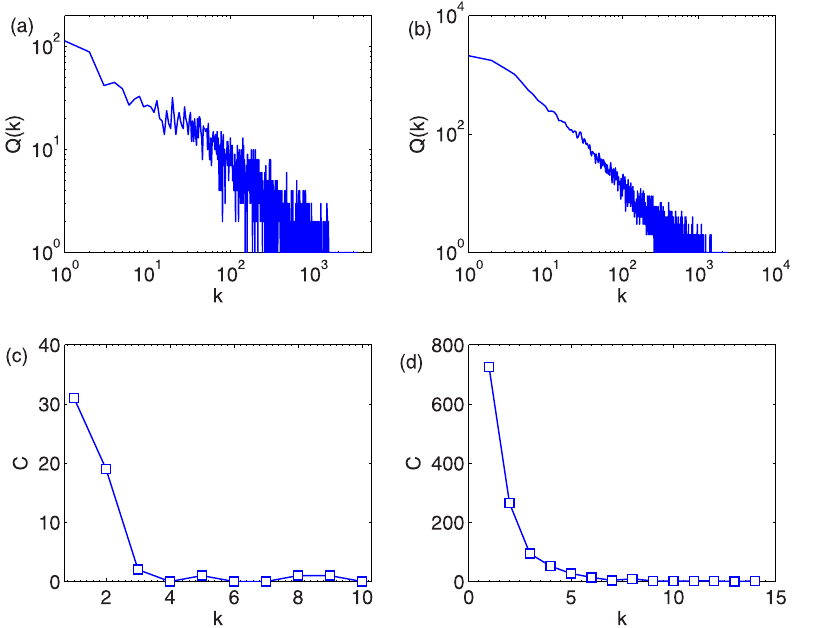
Figure 5. (a) and (b) are the frequency distribution of object degree in Movielens and Netflix, respectively. (c) and (d) are the relation between frequency C and k in movielens and Netflix, respectively.